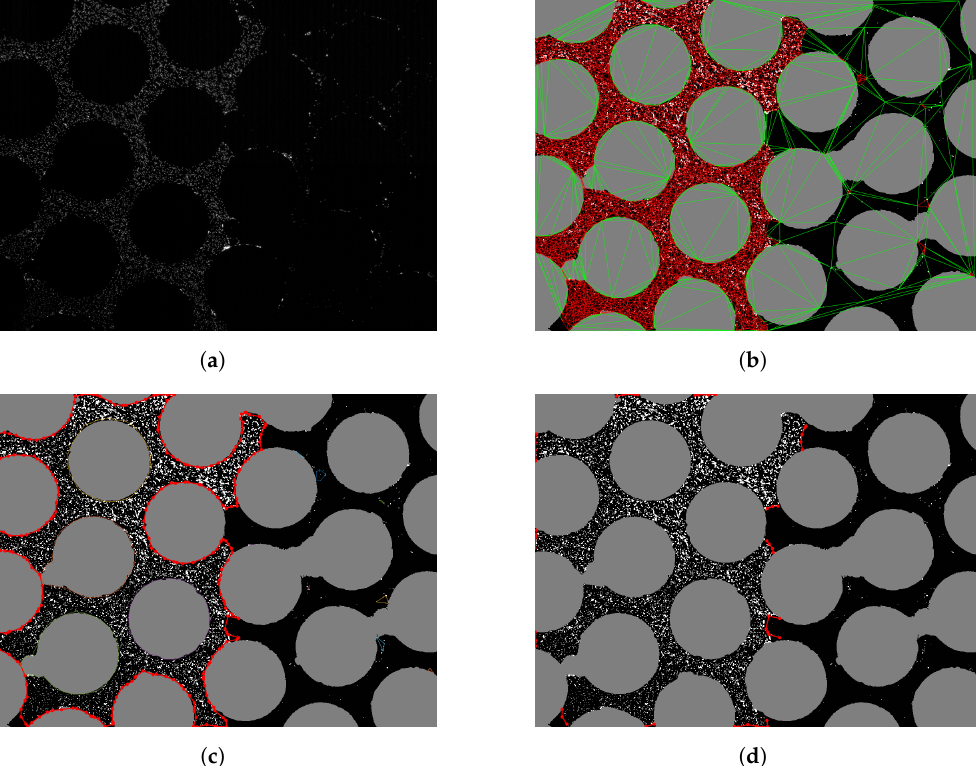
Figure 4. Extraction of displacement fronts from a frame. ( a ) a clean frame with well-represented wetting phase and non-wetting phase; ( b ) a clean frame with a well-represented wetting phase and non-wetting phase; ( c ) boundary of the phase mesh; ( d ) individual displacement